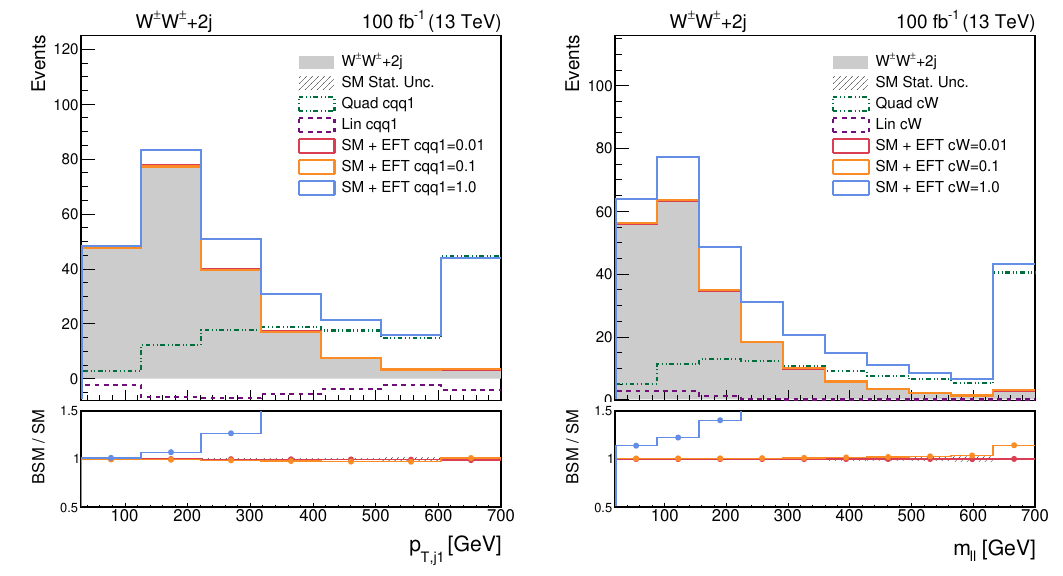
Figure 1 . Impact of two Wilson coefficients on representative kinematic distributions in the SSWW+2j process. Solid lines show the total prediction for one Wilson coefficient at a time, with c Λ 2 = 0 . 01 (red), 0 . 1 (orange) or 1 TeV − 2 (blue). The pure interference (quadratic) EFT α / component, normalized to c Λ 2 = 1 TeV − 2 , is indicated with a purple (green) dashed line. The α / SM prediction is shown in solid grey. The last bin comprises all the overflow